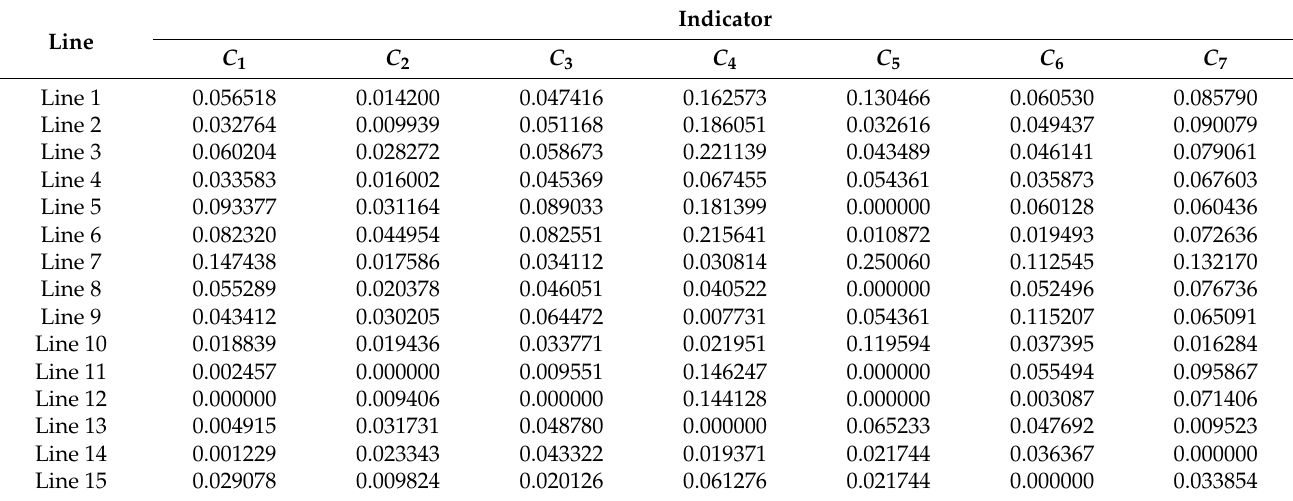
Table 7. Weighted decision matrix for the construction sequence of Line 1~15.